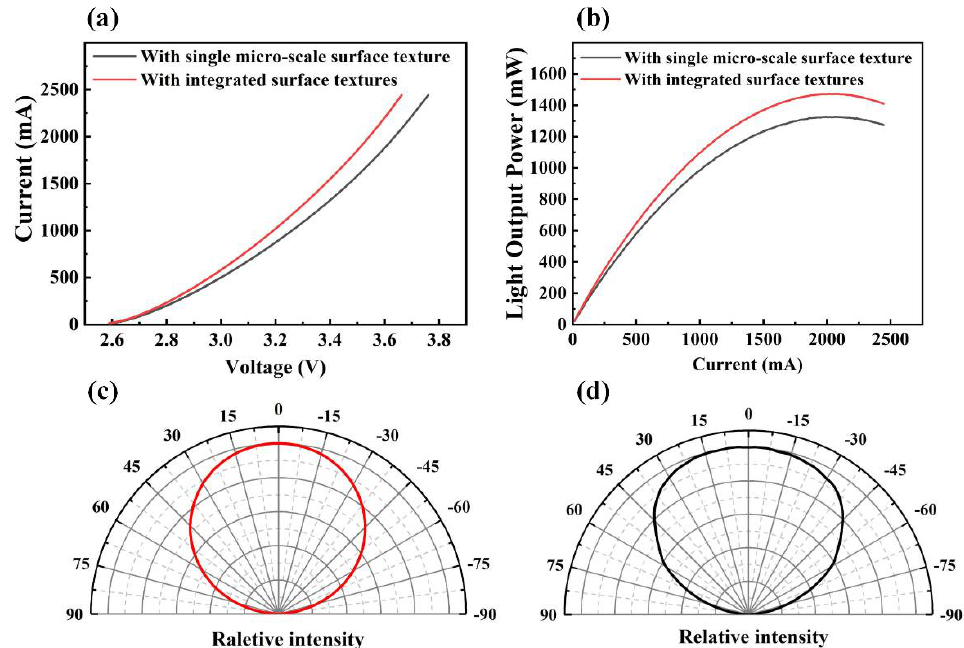
Figure 6. ( a ) L–I and ( b ) I–V characteristics of the fabricated vertical LEDs with single micro-scale surface texture and integrated surface textures. Far-field radiation profiles of the fabricated vertical LEDs with ( c ) integrated surface textures and ( d ) single micro-scale surface texture.